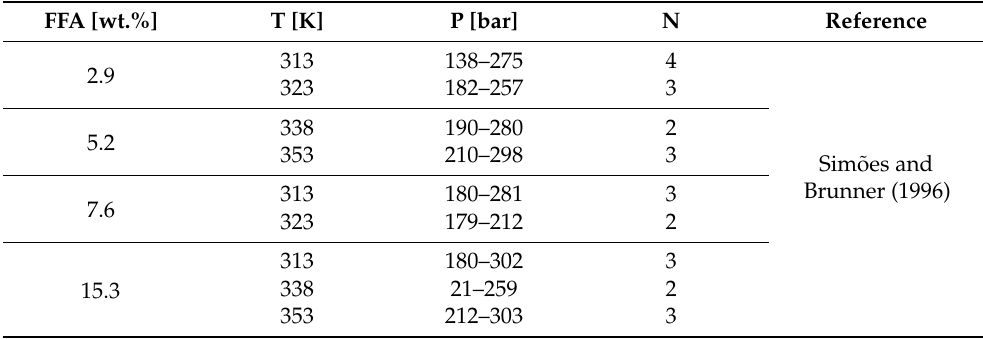
Table 14. State conditions (T, P) by high-pressure phase equilibrium data for the system olive oil-CO 2 [90].